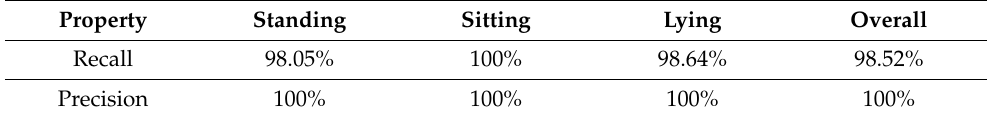
Table 6. Precision and recall in test dataset.